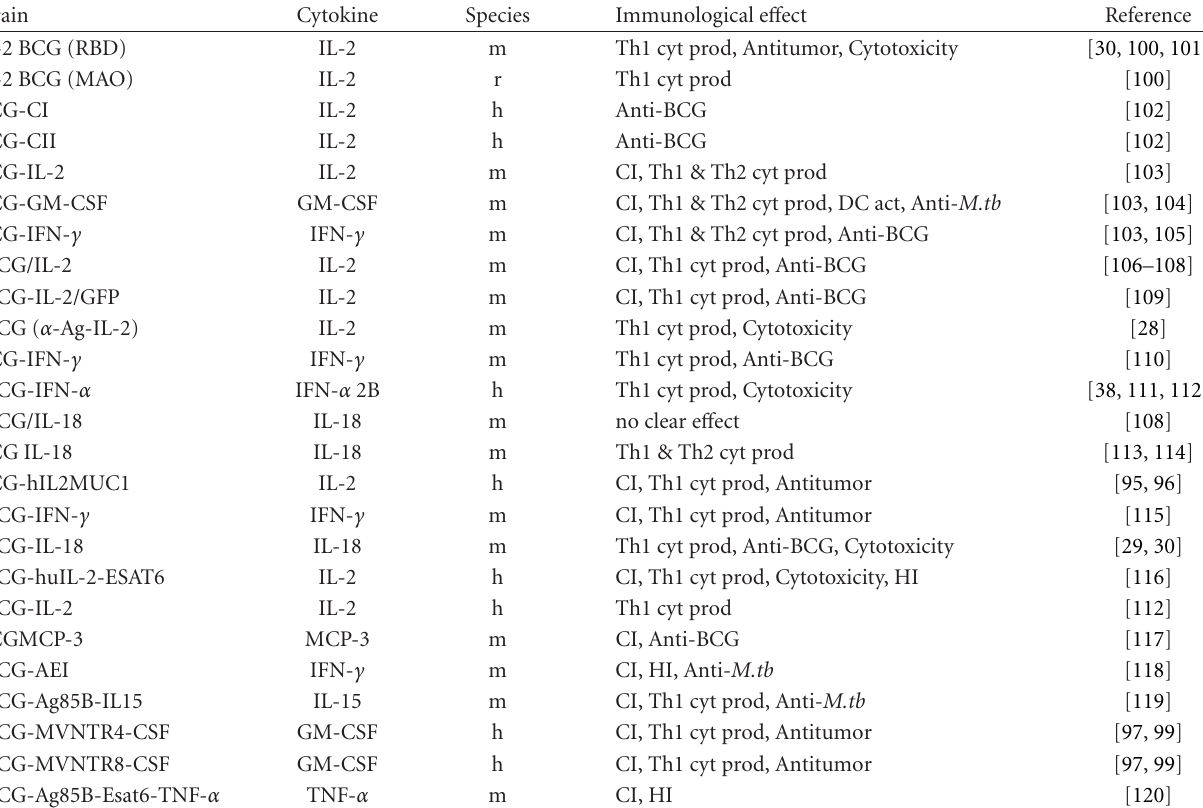
Table 1: Cytokine- and chemokine-expressing rBCG